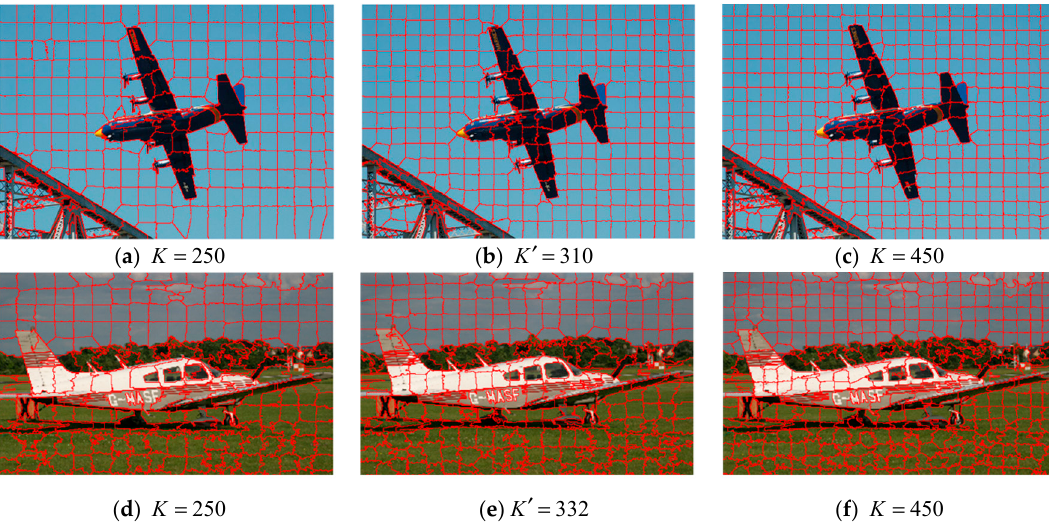
BR ASA UE Figure 5. The effect of the initial number of superpixels K on image accuracy. As shown in Figure 5, from the three evaluation indicators, the performance of image segmentation also improves with the increase of the initial number of superpixels K in a specific range. After that, it will be saturated later. In this state, although the value of K continues to increase,